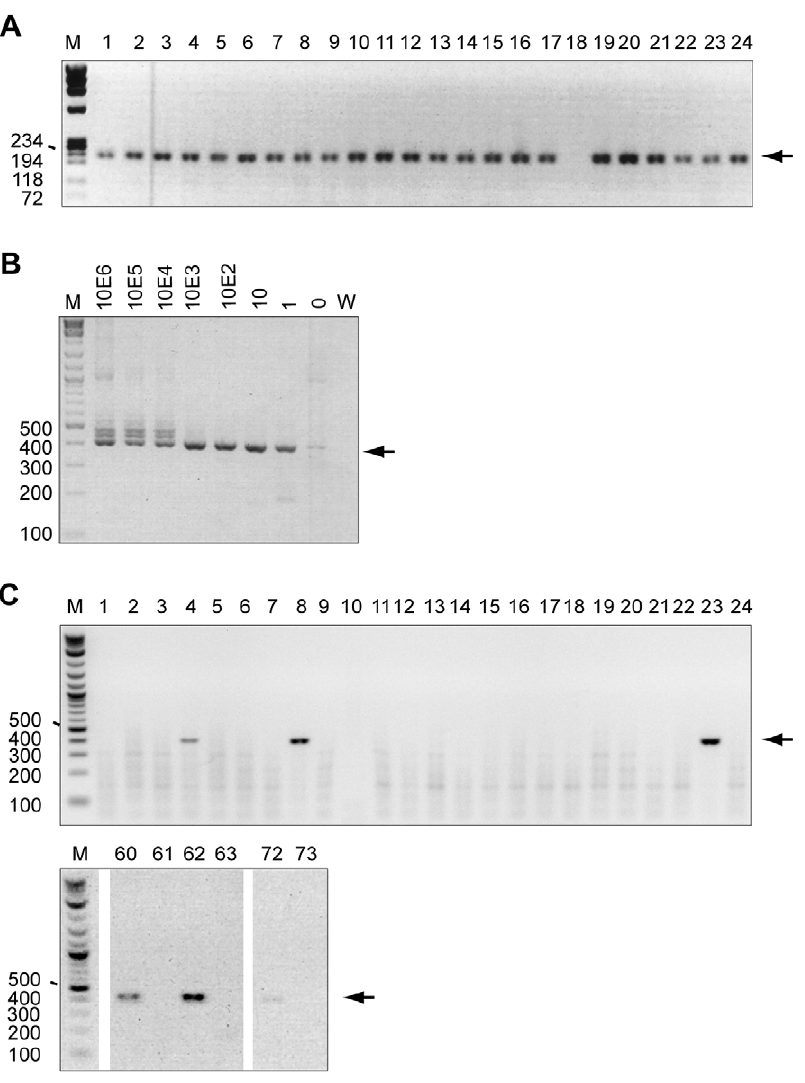
Figure 2. DNA integrity and detection of XMRV sequences in prostate cancer tissue DNA. Panels A-C show 1% agarose gels stained with ethidium bromide. For all, M indicates marker, W indicates water, numbers on the left indicate size of markers in base pairs, arrows indicate expected band size for each PCR. A) Detection of hgapdh in DNA isolated from PC tissue DNA samples 1–24 using single round PCR. Expected PCR product size, 225 base pairs. B) Standard curve to determine the detection limit of XMRV gag nested PCR. Ten-fold serial dilutions from 10 6 to 1 molecule per m l of XMRV plasmid (pcDNA3.1/VP62) were made in a background of an excess of human genomic DNA. Second round amplification products of the gag nested PCR are shown. Numbers above lanes indicate input number of molecules. Expected PCR product size 413 base pairs. Sequencing the slower migrating faint band in the ‘‘0’’ lane (human genomic DNA alone) showed this to be non-specific amplification of human genes (data not shown). C) Detection of XMRV gag sequences in DNA isolated from prostate cancer tissue samples. Second round amplification products from a subset of patients are shown as in (B). Samples 4, 8 23, 60, 62 and 72 are positive.